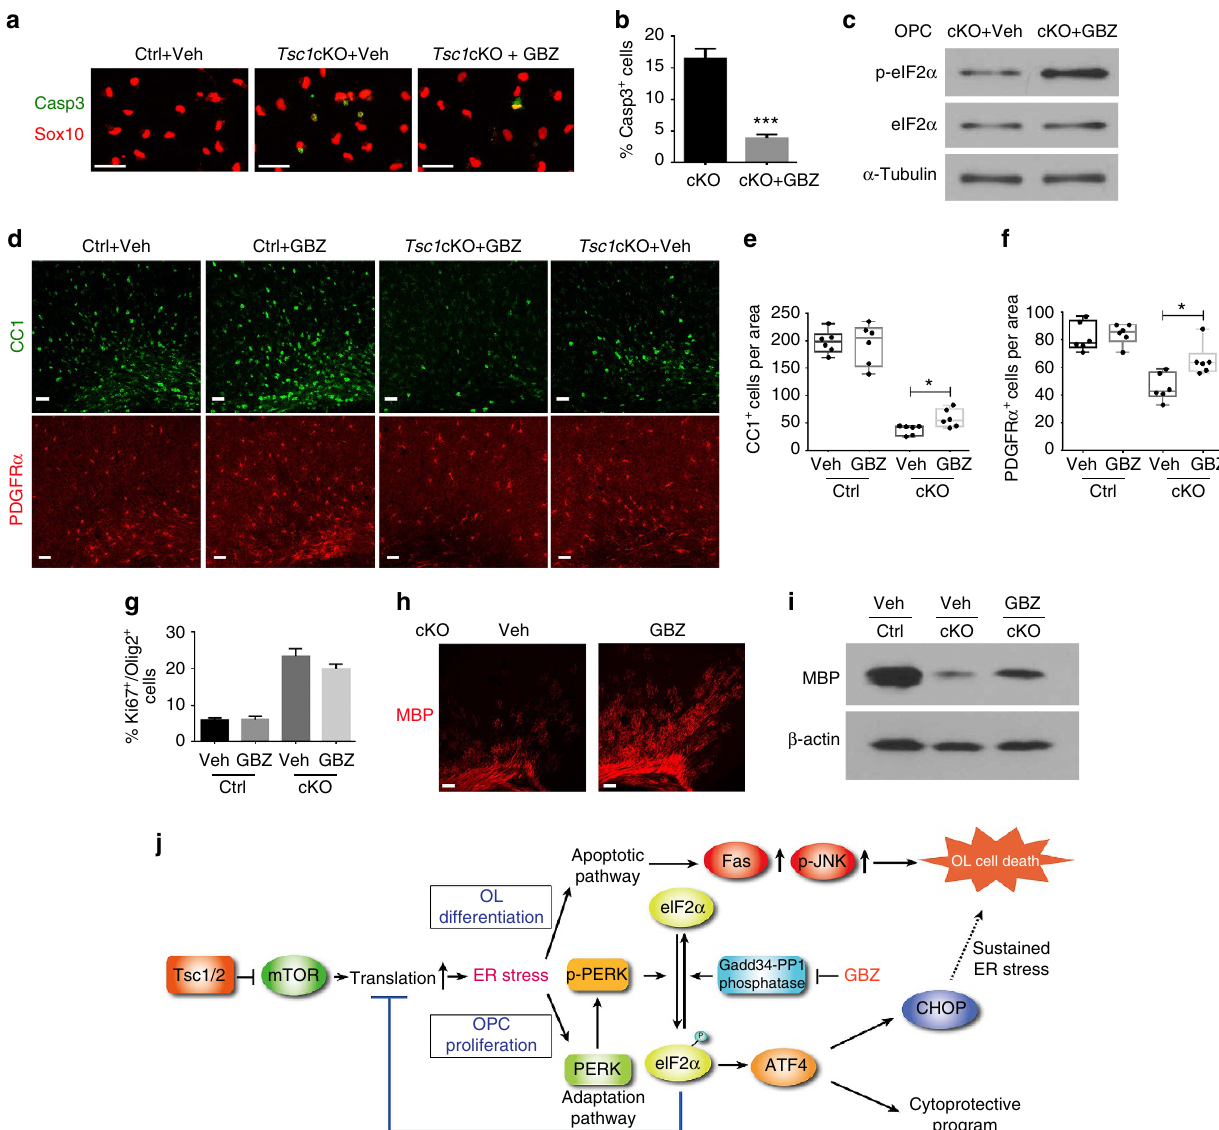
Figure 8 | Activation of p-eIF2 a -mediated signalling by guanabenz protects OLs and enhances myelination. ( a ) OPCs from control and Tsc1 cKO mice treated with 5 m M guanabenz for 24h in T3-containing differentiation medium immunostained with cl-Casp3 and Sox10. Scale bar, 25 m m. ( b ) The percentage of cl-Casp3 þ /Sox10 þ cells from guanabenz-treated OPCs from control and Tsc1 cKO mice. Data represent the mean ± s.e.m. from three independent experiments. *** P o 0.001, Student’s t -test. ( c ) Western blot analysis of p-eIF2 a and eIF2 a in OPCs from guanabenz or vehicle-treated Tsc1 cKO animals; a -tubulin, loading control. ( d ) The corpus callosum of control and Tsc1 cKO mice treated with vehicle and guanabenz from P7 to P14 was removed at P15, and immunostained with PDGFR a and CC1. Scale bar, 50 m m. ( e , f ) Numbers of CC1 þ cells in the corpus callosum ( e ) and PDGFR a þ cells in the cortex ( f ) from vehicle or guanabenz-treated control and Tsc1 cKO mice. Whiskers in boxplots show the minimum and maximum, boxes extend from the first to the third quartiles with cross lines at the medians. n ¼ 6 animals per group. * P o 0.05. One-way analysis of variance with Tukey’s multiple-comparison test. ( g ) Percentage of Ki67 þ and Olig2 þ cells from the cortex of control and Tsc1 cKO mice treated with vehicle or guanabenz. Data represent the mean ± s.e.m. from six animals. ( h ) Representative images showing MBP in the corpus callosum of control and Tsc1 cKO mice treated with vehicle or guanabenz. Scale bar, 50 m m. ( i ) Western blot analysis of MBP in the cortices from control and Tsc1 cKO animals treated with vehicle or guanabenz; b -actin, loading control. ( j ) A schematic diagram of Tsc1/2 mutation-induced ER stress in OL homoeostasis. Tsc1 loss leads to mTOR activation, resulting in excessive protein translation and ER stress by activating the PERK–eIF2 a –ATF4 adaptation pathway and Fas/p-JNK apoptotic programs. Sustained ER stress coupled with apoptotic pathway activation contributes to the cell death during OL differentiation in Tsc1 mutants. Inhibition of Gadd34-PP1 by guanabenz (GBZ) enhances p-eIF2 a -mediated adaptive responses and partially rescues OL death and myelination defects in Tsc1 partially rescued myelinogenesis defects. Although a hallmark of indicate that disruption of OL homoeostasis in Tsc1 mutants contributes to hypomyelination and OL loss seen in TSC patients, growth, the present study indicated that sustained mTOR and that modulation of ER stress responses may be beneficial for TSC therapy to restore myelination deficits. The dysmyelinating phenotype in Tsc1 mutants is likely loss in TSC patients 8,9 . We do not observe other CNS mediated through constitutive mTOR activation, since rapamycin